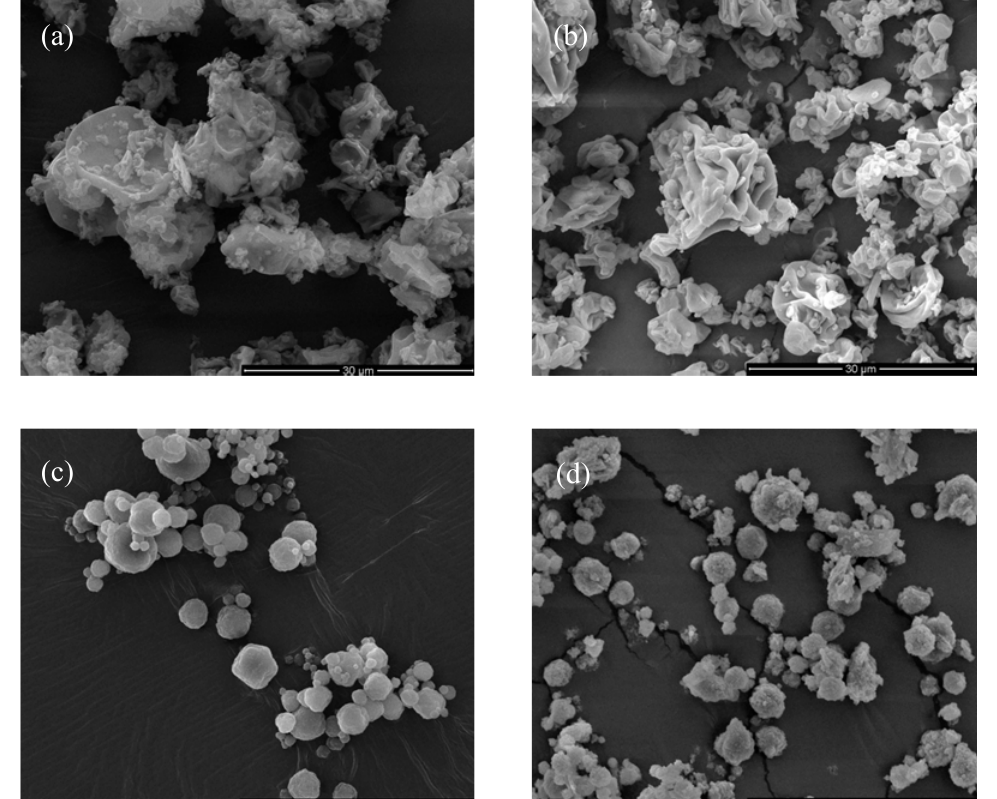
Figure 4. Scanning electron microscope (SEM) pictures of formulations: ( a ) F 4 , ( b ) F 13, ( c ) F 19 , ( d ) F 20 under 5000x magnification.